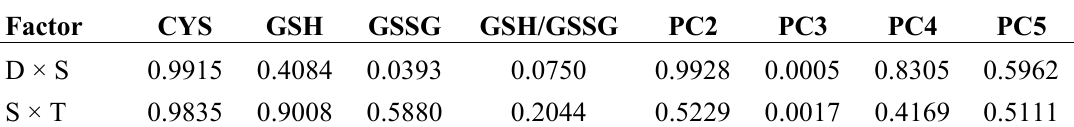
Table 5 . Relationship between Date of sample (D) and Species (S) and between Species (S) and Treatment (T).